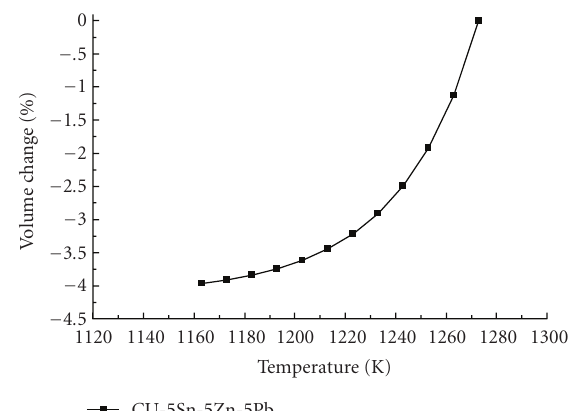
Figure 10: Modeling results of the solidification shrinkage in Cu- 5Sn-5Zn-5Pb alloy